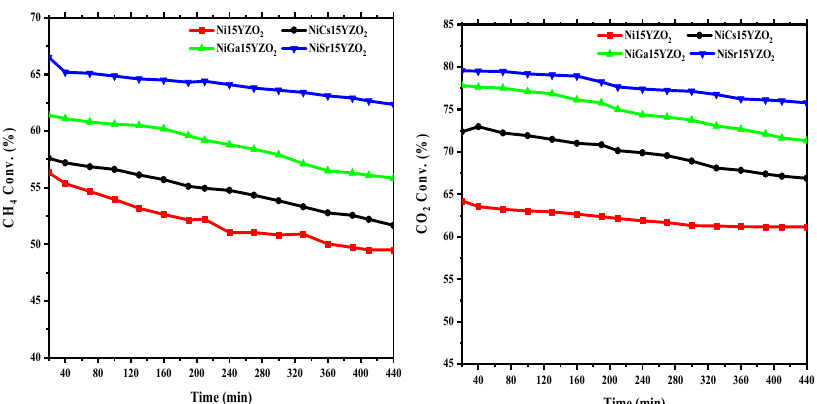
Figure 8. CH 4 and CO 2 % conversions for 5Ni15YZr, 5NiCs15YZr, 5NiGa15YZr, and 5NiSr15YZr catalysts.